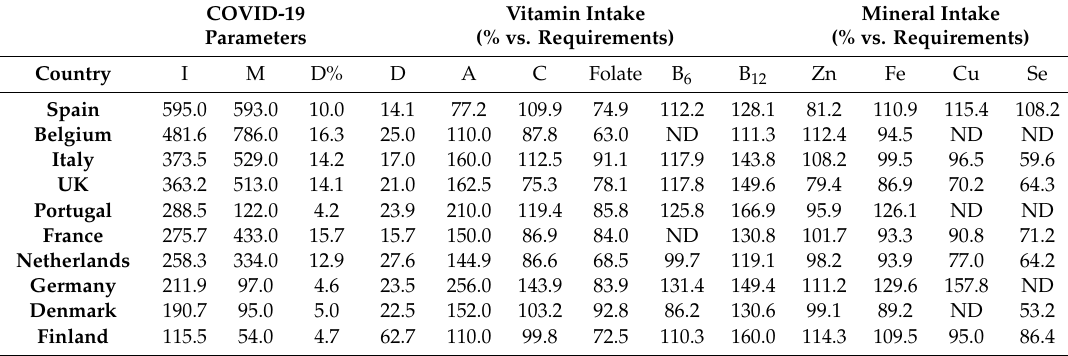
Table 2. COVID-19 epidemiological parameters and Vitamin and Mineral population intake levels (% vs. requirements) per country vs. recommended intake